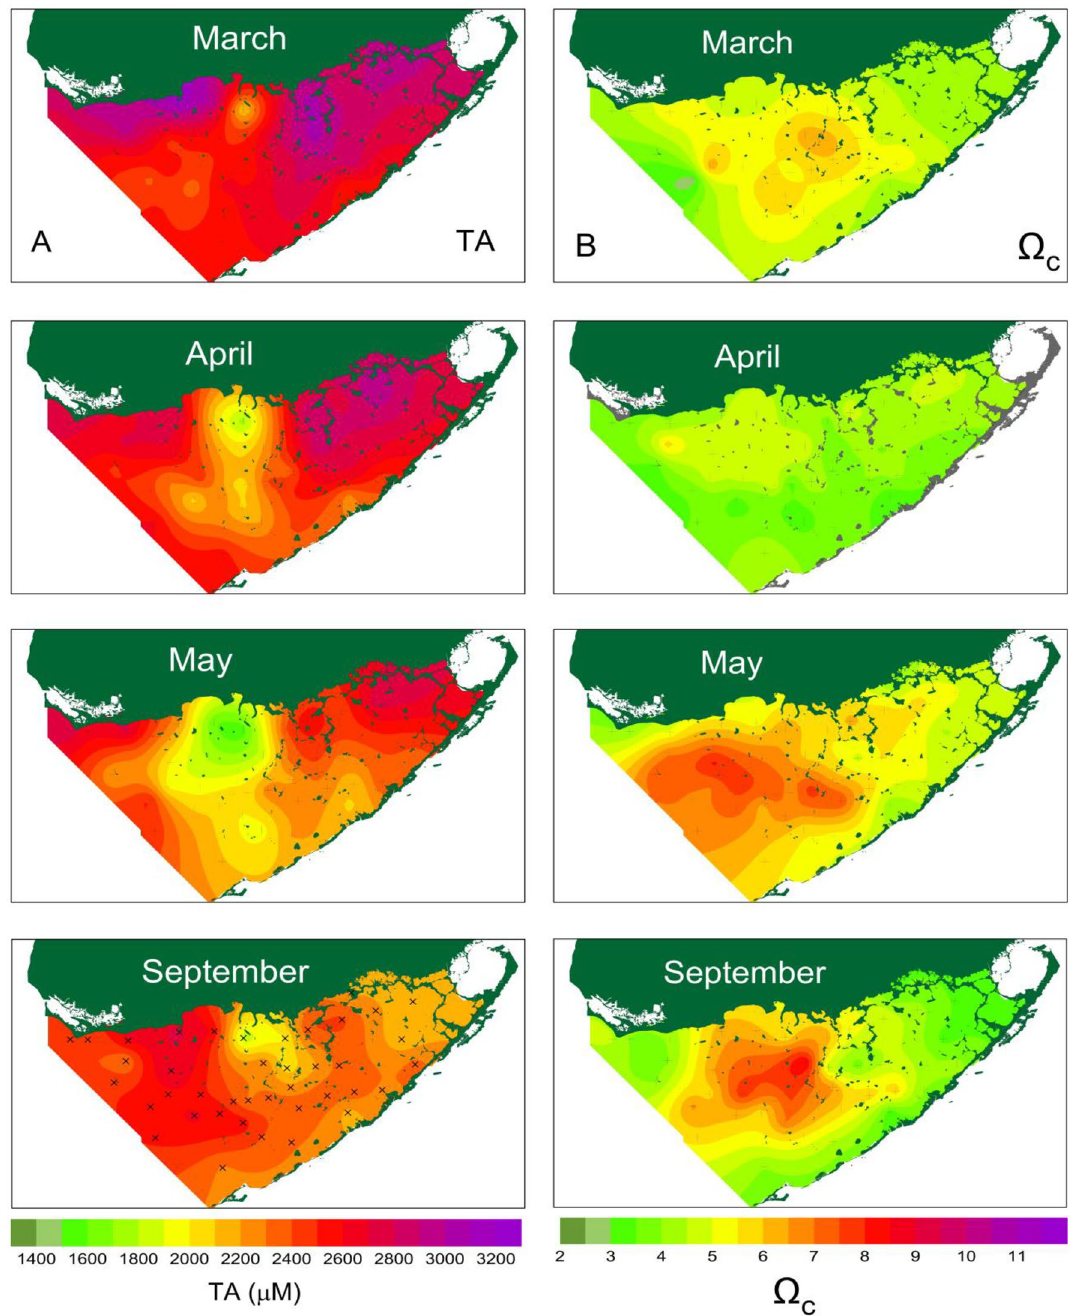
Figure 2. Seasonal changes in spatial distribution of ( A ) total Alkalinity (TA,1400–3200 µM, interval 200 µM) and ( B ) saturate state Ω c (2–11, interval 1) in Florida Bay waters during year 2011. The contour maps were generated using a commercial software Surfer version10 (https:// www. golde nsoft ware. remained at the station 6 but high dissolved silicon water was spreading south and west directions. As the season progressed into fall, the dissolved silicon concentration decreased significantly and the high dissolved silicon water seen in summer had completely disappeared. As shown in 2011 data the maximum pH and dissolved silicon concentrations are always occurred at the center of cyanobacteria blooms in the bay. The monthly maximum dissolved silicon concentrations observed in the bay from 1999 to 2012 are plotted together with observed pH maxima from 2006 to 2012 in Fig. 4. Maxima dissolved silicon concentrations are low in winter and reach peak values every summer. The highest dissolved sili- con concentration observed in Florida Bay was 300 µM in summer of 2007. During winter seasons, dissolved sili- con concentrations were below 20 µM before 2005. After high dissolved silicon input in 2007 summer, winter dissolved silicon increased to above 50 µM and reached to 100 µM in 2011 and 2012 in Florida Bay. The measured